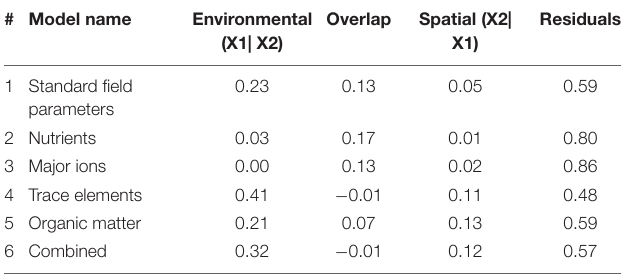
TABLE 4 | Variation partitioning of bacterioplankton community by environmental variables and spatial data shows trace elements explain more changes in composition than any other environmental or spatial